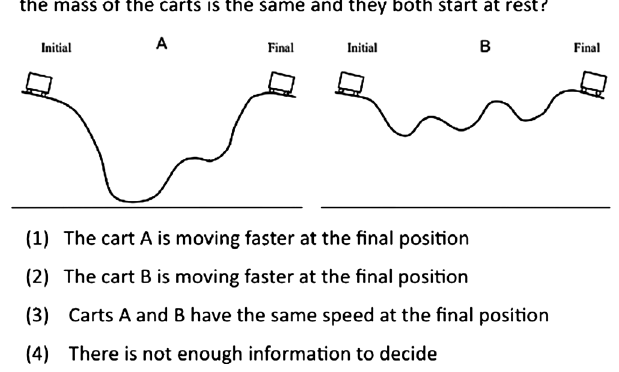
2.FIG. 5. Problem 1 used in studies 1 and 2.